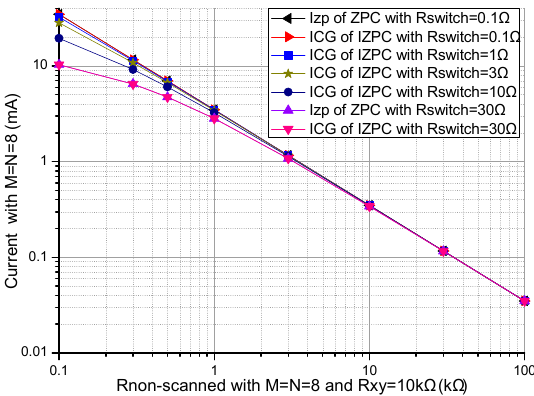
Figure 7. Effect of R non-scanned and R switch on the currents of the basic circuit and those of the improved circuit.